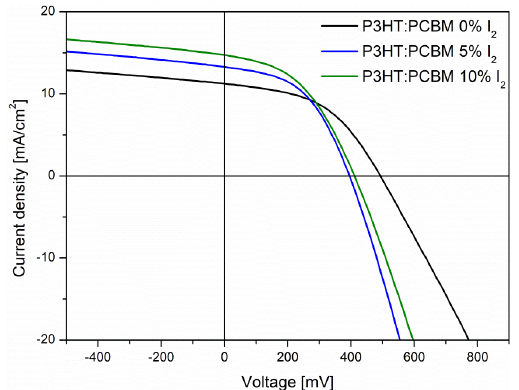
Figure 12. J-V characteristics of studied BHJ devices.